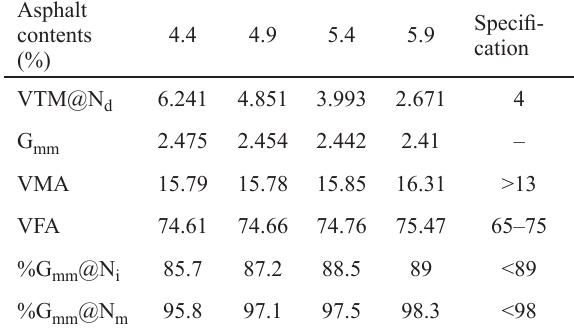
Table 3. Superpave mix design results